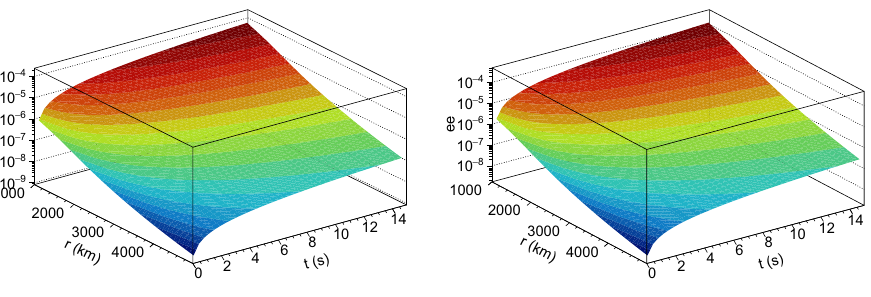
Figure 2. Enantiomeric excesses of zwitterionic alanine (left) and cationic isovaline (right) as a function of time and orbital radius of meteoroids about a neutron-star